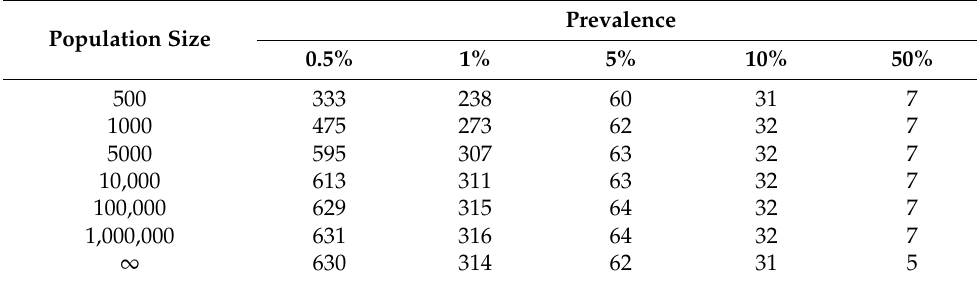
Table 2. Screening sample sizes with varying threshold prevalence and population size. Based on a test specificity of 100%, test sensitivity of 95%, and a confidence interval of 95%. Calculations were made at https://epitools.ausvet.com.au/ (accessed on 23 August 2022)